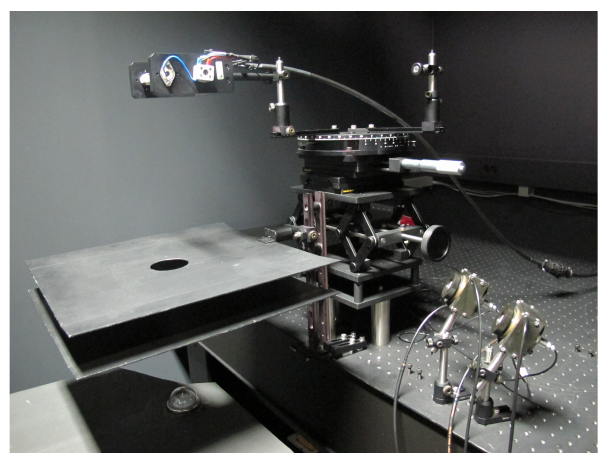
Figure 2. Lamp measurement with the Brewer spectroradiometer. The diffuser of the Brewer is in the bottom left corner under the baffles. The lamp is placed in the lamp holder over the baffles. The goniometer is seen in the middle, and the UV-A and UV-B sensors in the bottom right corner.